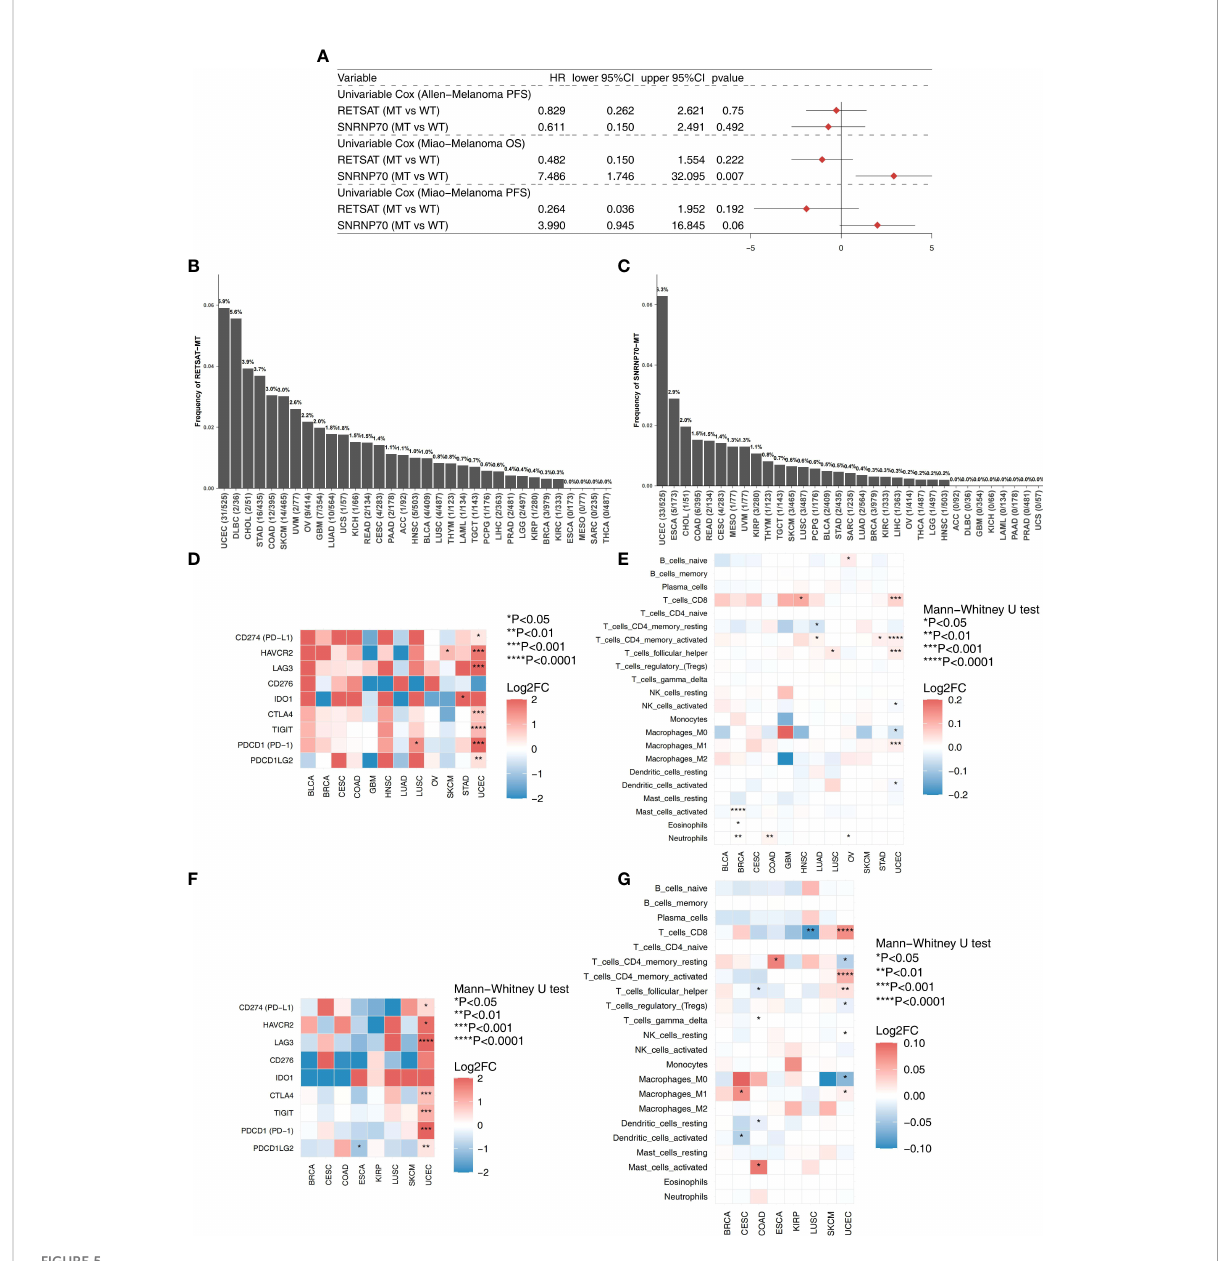
FIGURE 5 (A) The univariable cox regression model of the top mutated genes (RETSAT and SNRNP70) in the two ICIs-treated cohorts (Allen-Melanoma and Miao-Melanoma). (B) The mutation frequencies of the RETSAT in the 33 cancer types of TCGA database. (C) The mutation frequencies of the SNRNP70 in the 33 cancer types of TCGA database. (D) Heatmap depicted the logFC of the expression levels of the immune checkpoint molecules between the RETSAT-MT and RETSAT-WT among multiple cancer types (TCGA database). (E) Heatmap depicted the logFC of the immune cells scores estimated by the CIBERSORT method between the RETSAT-MT and RETSAT-WT among multiple cancer types (TCGA database). (F) Heatmap depicted the logFC of the expression levels of the immune checkpoint molecules between the SNRNP70-MT and SNRNP70-WT among multiple cancer types (TCGA database). (G) Heatmap depicted the logFC of the immune cells scores estimated by the CIBERSORT method between the SNRNP70-MT and SNRNP70-WT among multiple cancer types (TCGA